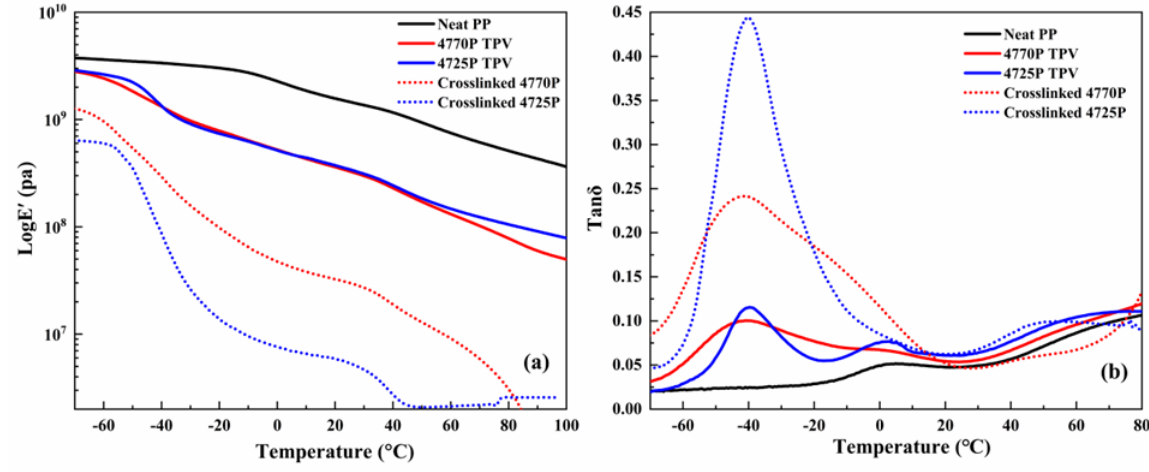
Figure 6. Storage modulus ( a ) and tan δ ( b ) of neat PP, TPVs, and crosslinked EPDMs.